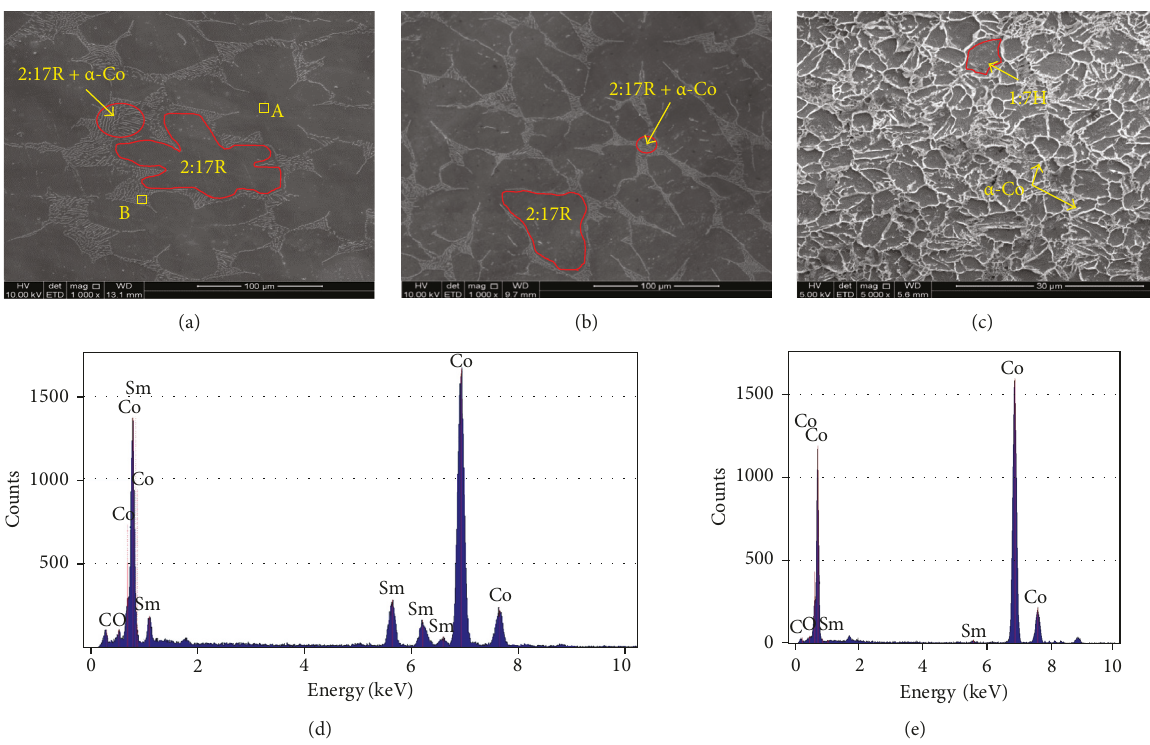
Figure 2: SEM images of SmCo 10 alloys. (a) As-cast alloy. (b) Annealed alloy. (c) As-spun ribbons. (d) Energy spectrum of region A in (a). (e) Energy spectrum of region B in